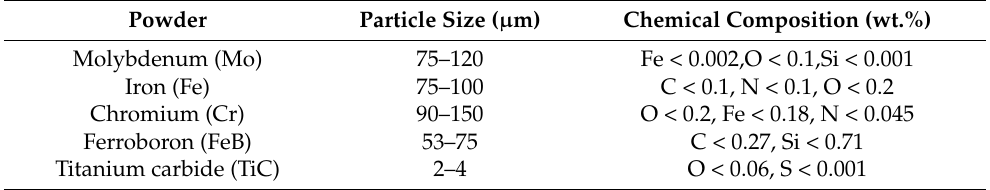
Table 1. The particle size and chemical composition of the alloy powders. Powder Particle Size ( µ